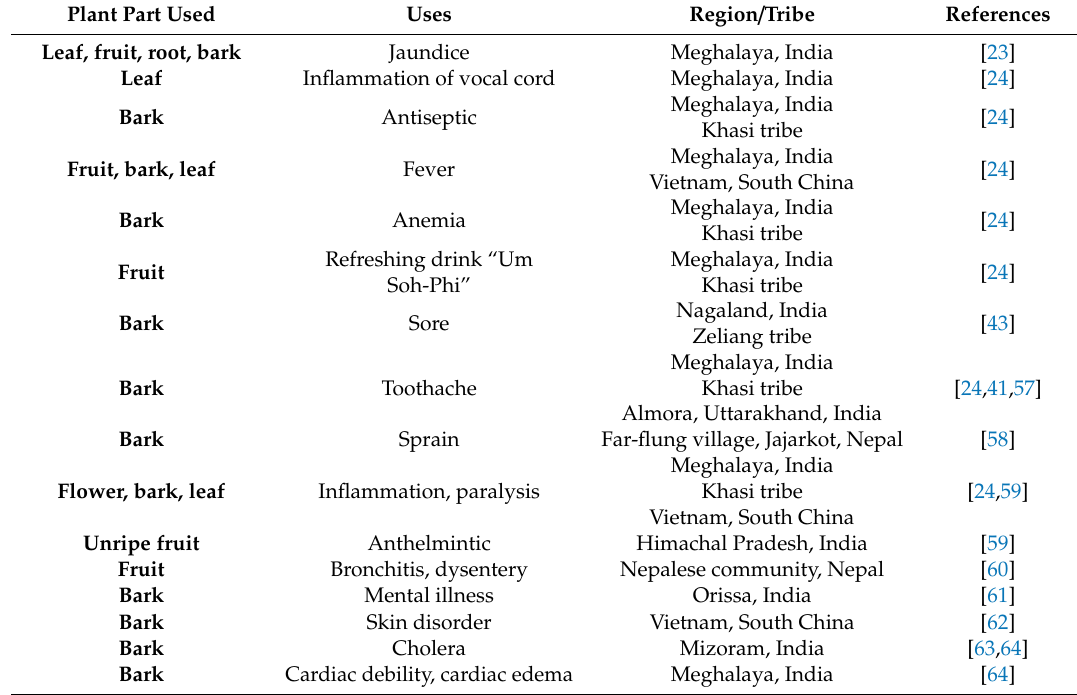
Table 2. Ethomedicinal uses of M. esculenta.